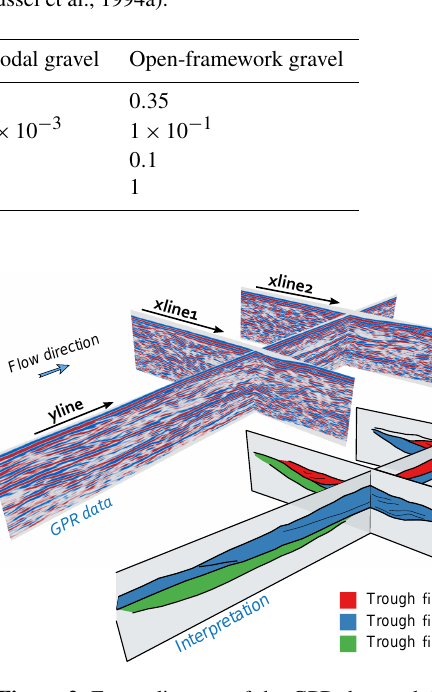
Figure 2. Fence diagram of the GPR data and their interpretation. The black arrows indicate the GPR survey